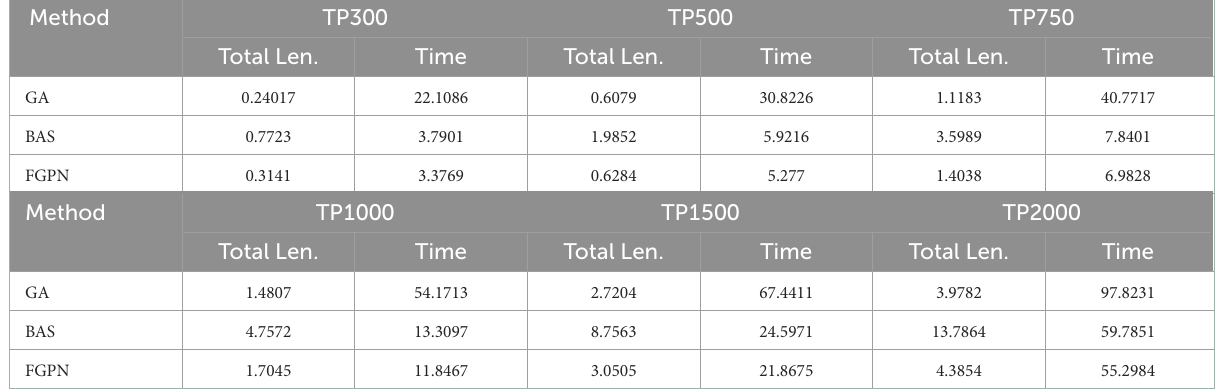
TABLE 2 The relationship between the solution time and the total moving distance and the scale of the task nodes when the number of target task nodes in the task cluster is about 40. The unit of total Len. in the table is 10 6 m , and the unit of Time is seconds.